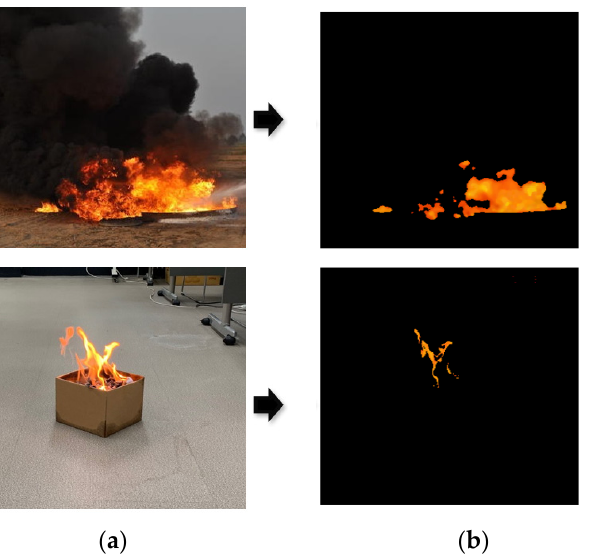
Figure 2. HSV color conversion of flame images. ( a ) Original flame images; ( b ) HSV color conversion images within the range.